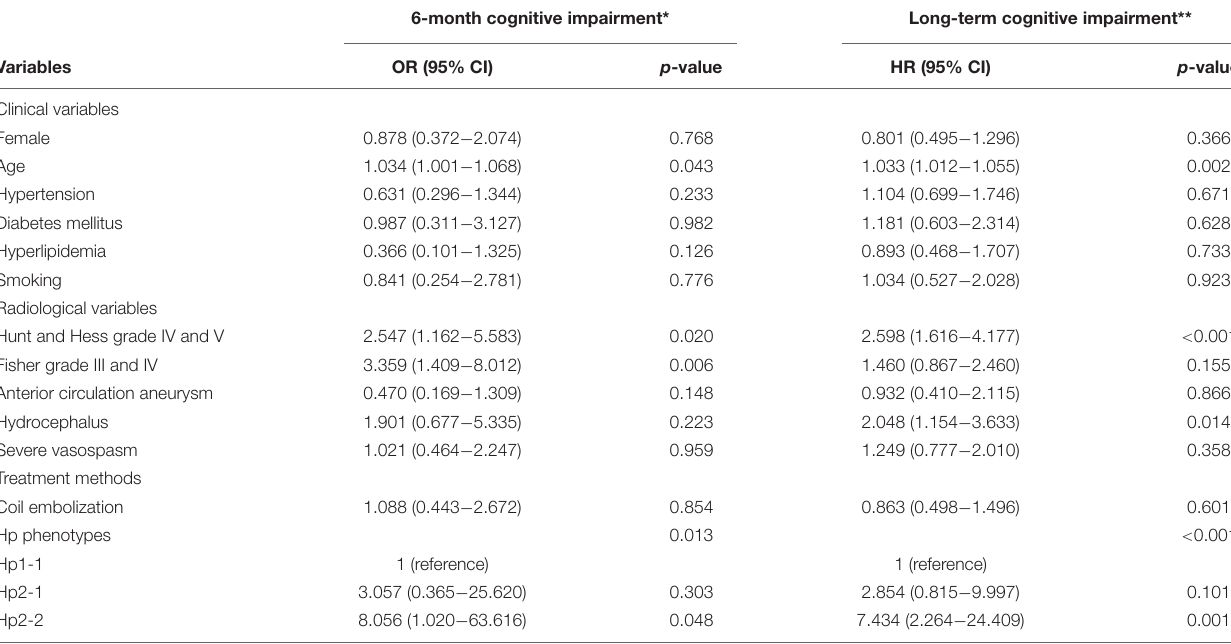
TABLE 3 | Multivariable logistic regression analysis of variables associated with 6-month cognitive impairment and Cox proportional-hazards regression analysis of long-term cognitive impairment following subarachnoid